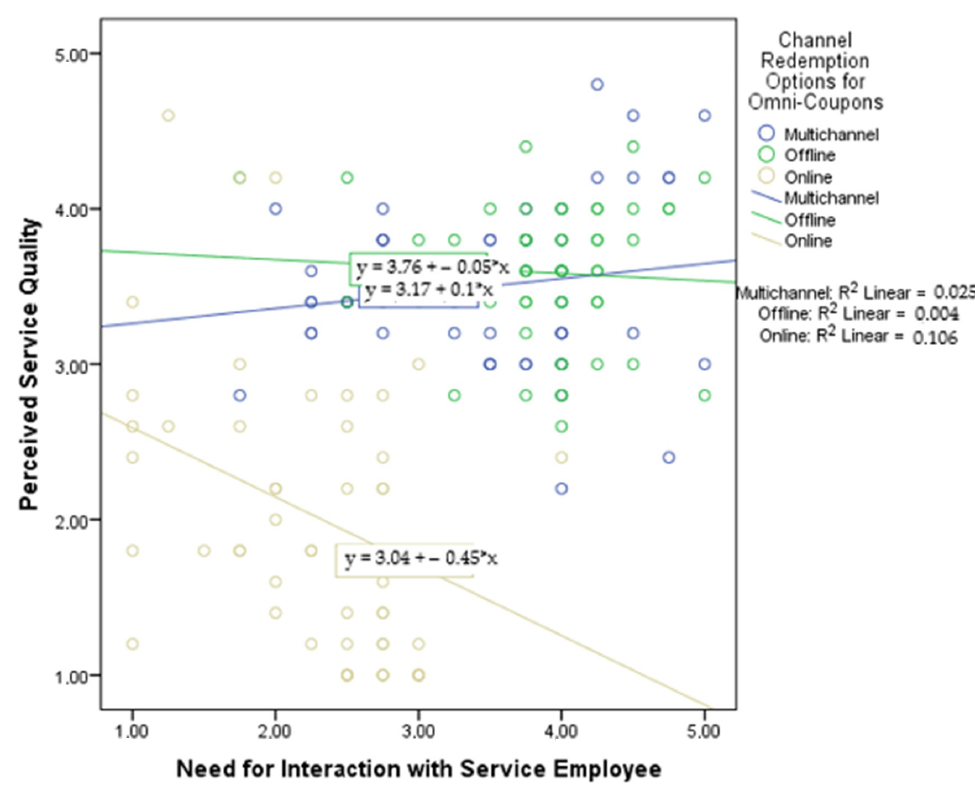
Figure 3. Perceived service quality concerning the need for interaction with service employees across channel redemption options for omni-coupons.